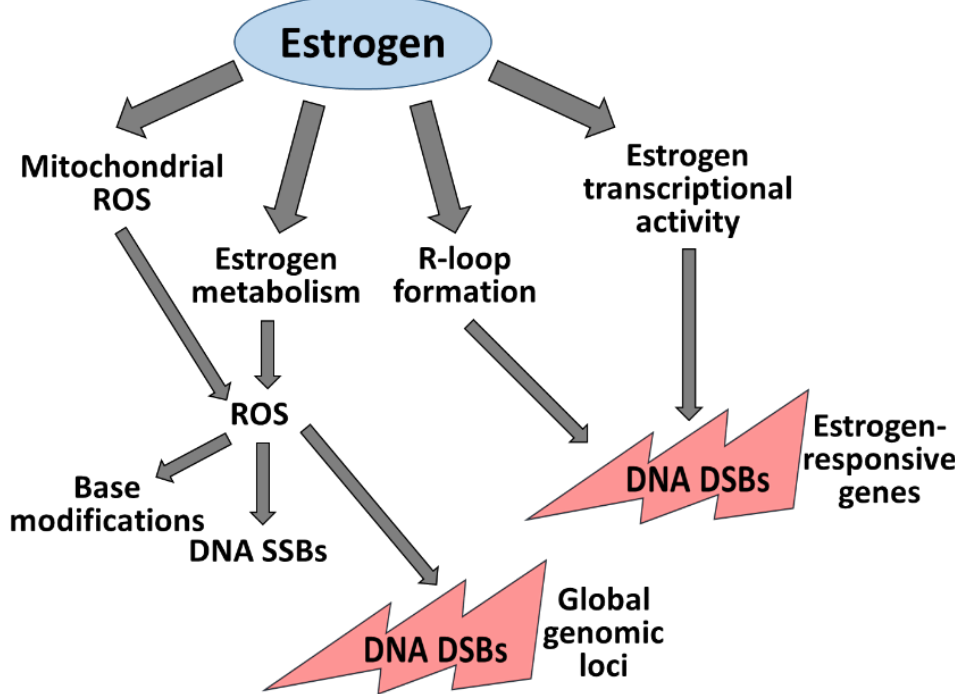
Figure 1. Estrogen induces DNA damage in cells. Estrogen prompts hydrogen peroxide based mitochondrial ROS and a bypass of estrogen metabolism is ROS. ROS leads to several types of DNA lesions, including base modifications, SSBs and DSBs. These DSBs are dispersed throughout the genome. Estrogen stimulus increases R-loop formation, which are processed into DSBs, in estrogen-responsive elements. Besides, estrogen addition induces DSBs at the promoters of estrogen-responsive